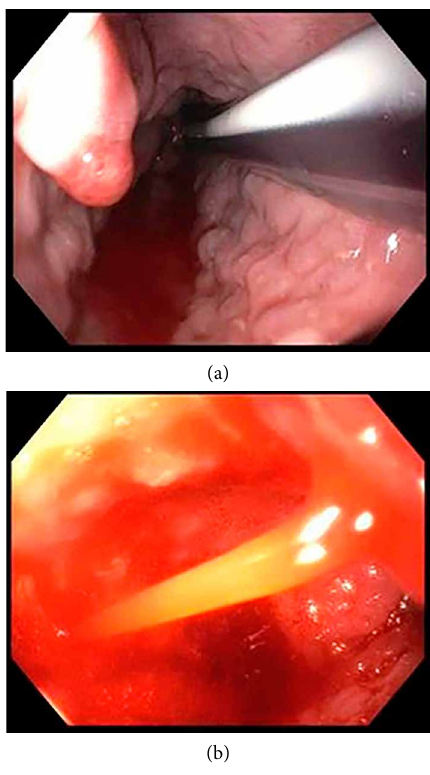
Figure 2: New onset esophageal varices 17 days after